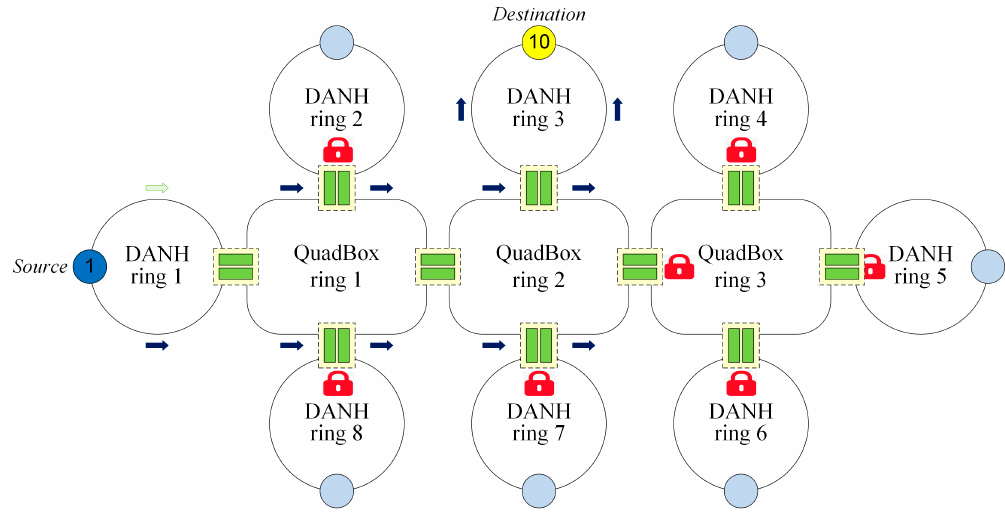
Figure 12. Forwarding a unicast frame using the EFA approach.